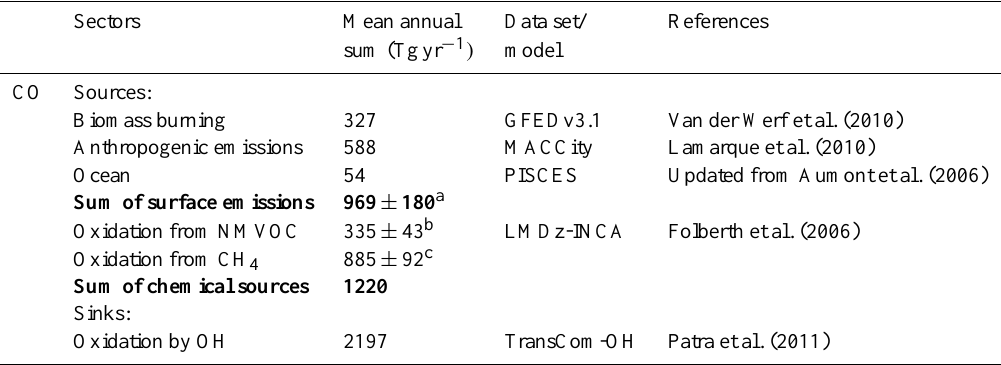
Table 1. Prior data sets for the sources and sinks of CO. Mean annual sums are calculated for the period from 2002 to 2011. The global annual prior error budgets are reported and the TransCom-OH field is used. The sum of surface emissions and chemical sources are shown in bold.